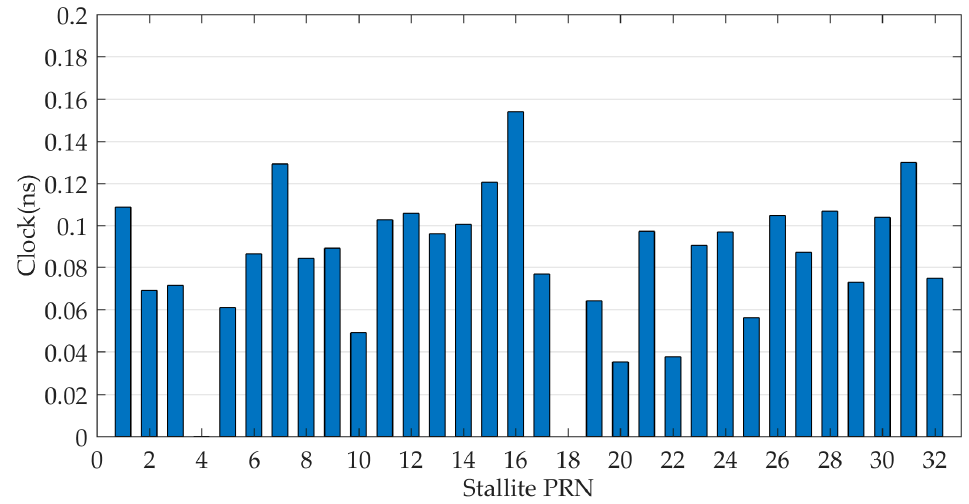
Figure 6. Seven-day average-STD clock errors of all available GPS satellites.